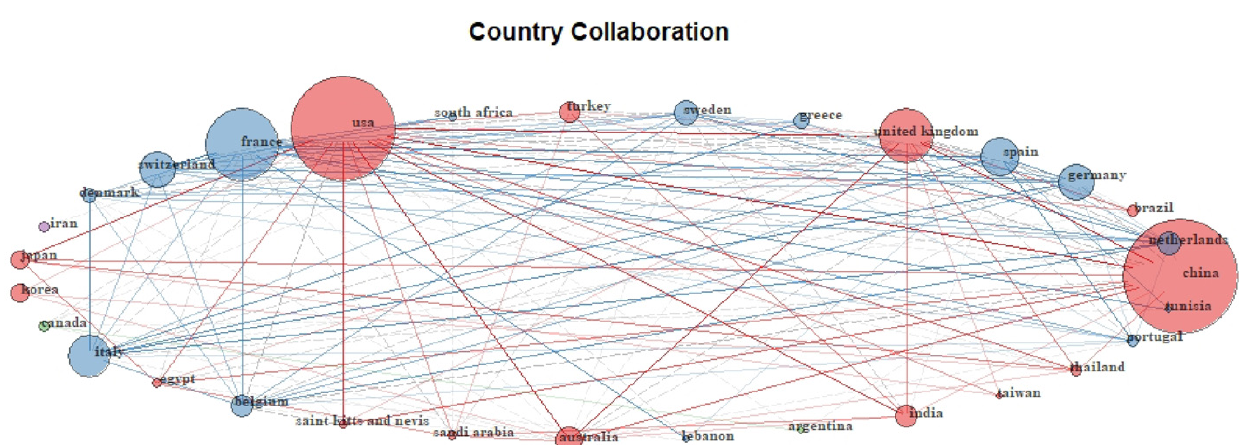
Figure 3. International collaboration analysis for top 30 active countries. Each node in the figure symbolizes a different country’ collaboration with other countries. The node’s diameter corresponds to the strength of collaboration. Links represent international collaboration pathways between countries. Cluster of countries having similar cluster color most probably represents a closely related research group. Links represent the strength of